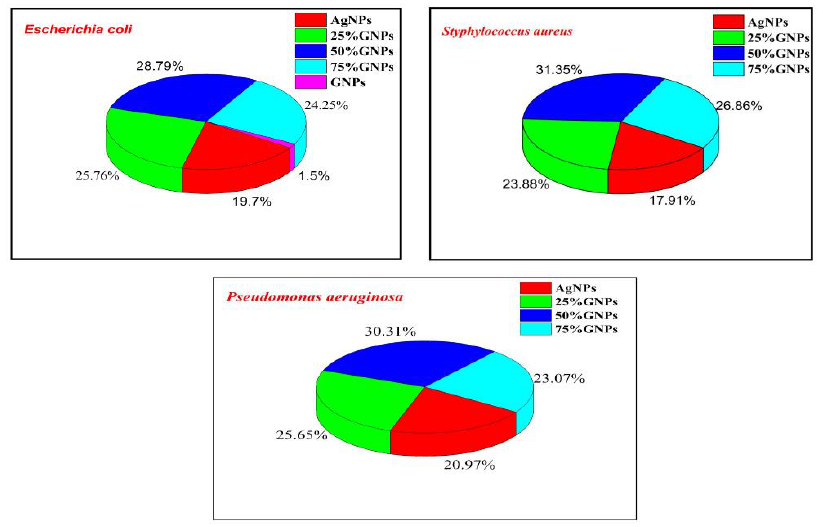
Figure 9. % Growth inhibition in bacterial pathogens with varying Ag-GNPs nanocomposites. Table 1. ZOI generated by AgNPs, (Ag) 1 − x (GNPs) x and GNPs against bacterial